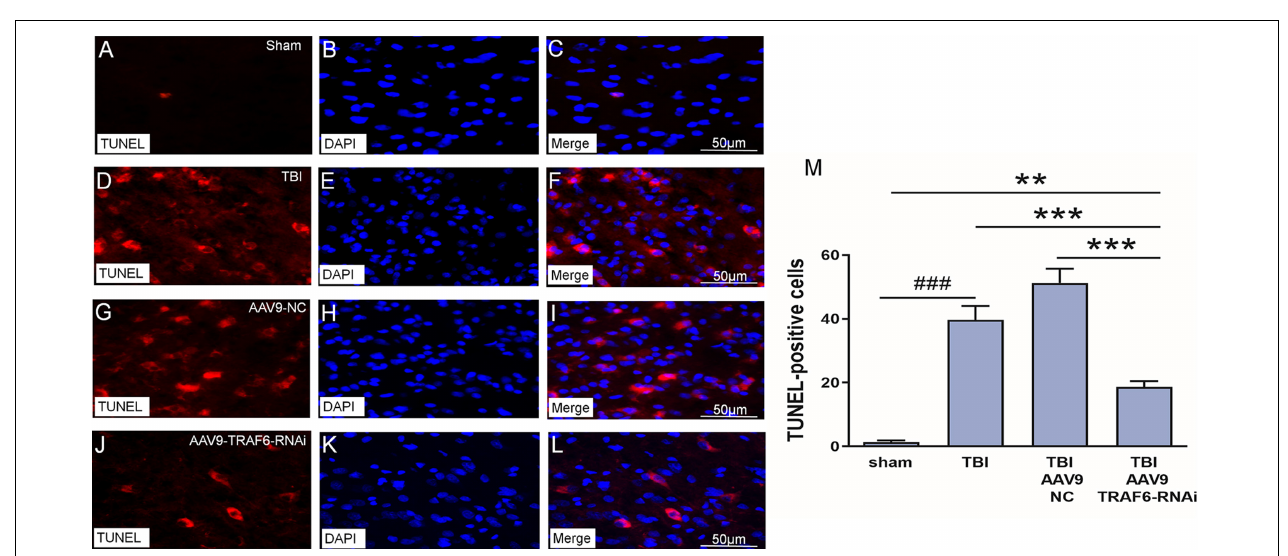
FIGURE 5 | Knockdown of TRAF6 reduced apoptotic death rate following TBI. TUNEL (red), DAPI (blue), and TUNEL+DAPI (merged) images showing apoptotic nerve cell. (A–C) Sham-treated rats. (D–F) TBI model rats. (G–I) TBI model rats injected with AAV9-NC. (J–L) TBI model rats injected with AAV9-TRAF6-RNAi. Scale bars are equal to 50 µ m. (M) AAV9-TRAF6-RNAi treatment decreased nerve cell apoptosis. Values are presented as mean ± SEM. ** P < 0.01 and *** P < 0.001 vs. AAV9-TRAF6-RNAi group. ### P < 0.001 vs. sham